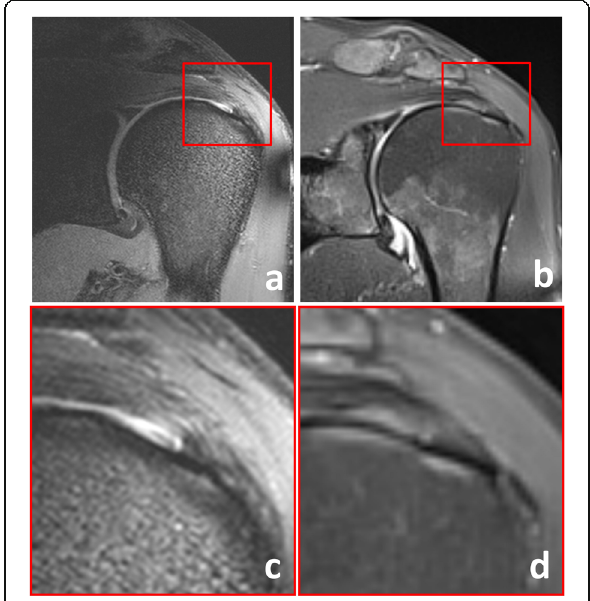
Fig. 2 Example of overrating with 7-T MRI. In this 52-year-old male patient, a partial tear of the supraspinatus tendon was suspected according to 7-T MRI based on the signal increase and fluid collection near to the footprint ( a , c ). At 1.5T ( b , d ), these changes are less impressive. Arthroscopy revealed little scar tissue and slight thinning of the tendon, but no tendinopathy or tear. Retrospectively, the signal changes observed at 7T must be assigned to B 1+ inhomogeneities and/